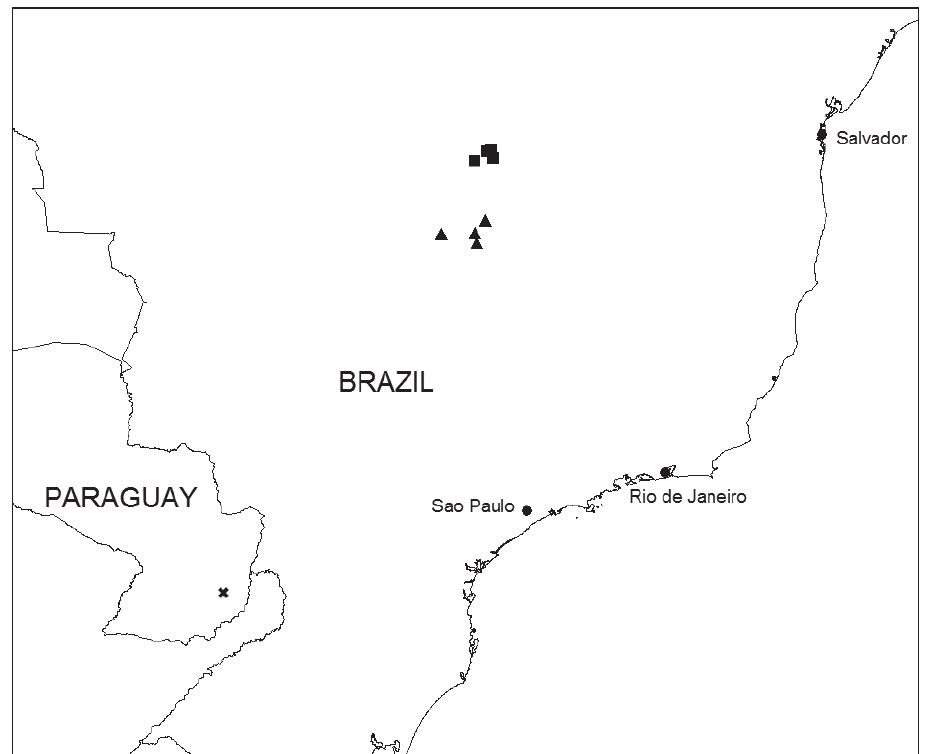
Figure 2. Map of Eastern Brazil and Paraguay showing distribution of Ipomoea attenuata ( ▲ ), I. dasy- carpa ( ■ ) and I. dolichopoda ( Ò